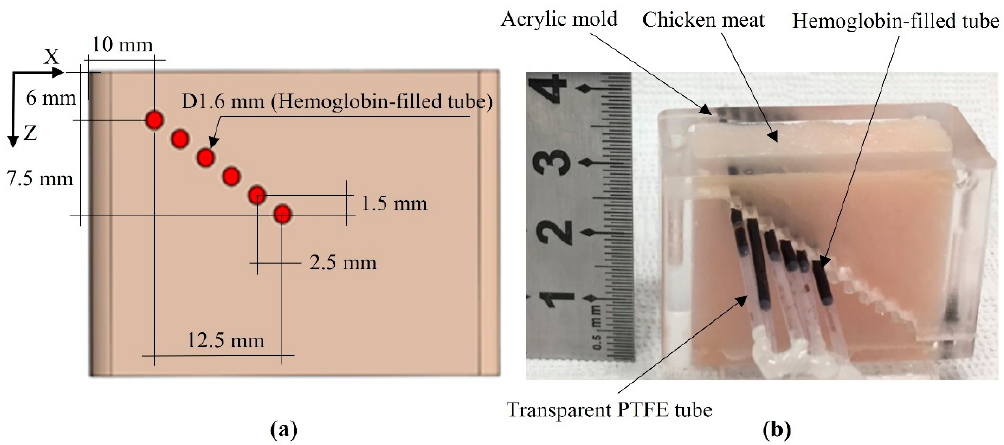
Figure 8. (a) The structure and (b) a photograph of the chicken-hemoglobin (CHb) phantom. The polytetrafluoroethylene (PTFE) tube with an inner diameter of 1.6 mm, wall thickness of 0.038 mm, and transparent color.